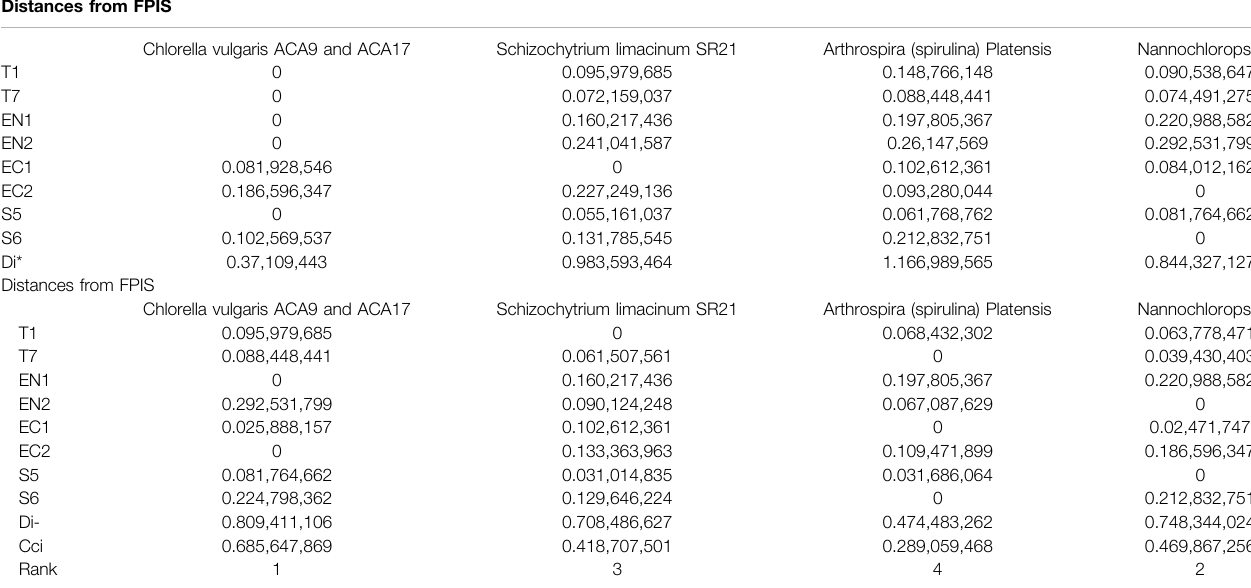
TABLE 10 | Distances from FPIS and FNIS and the